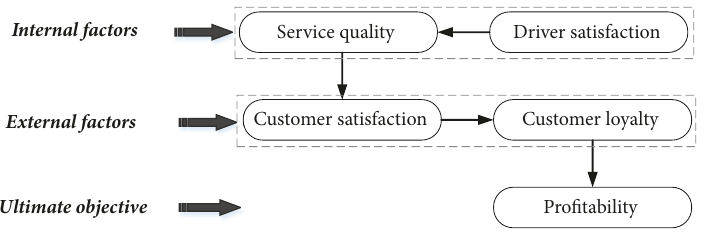
Figure 1: The process of making profits in the service